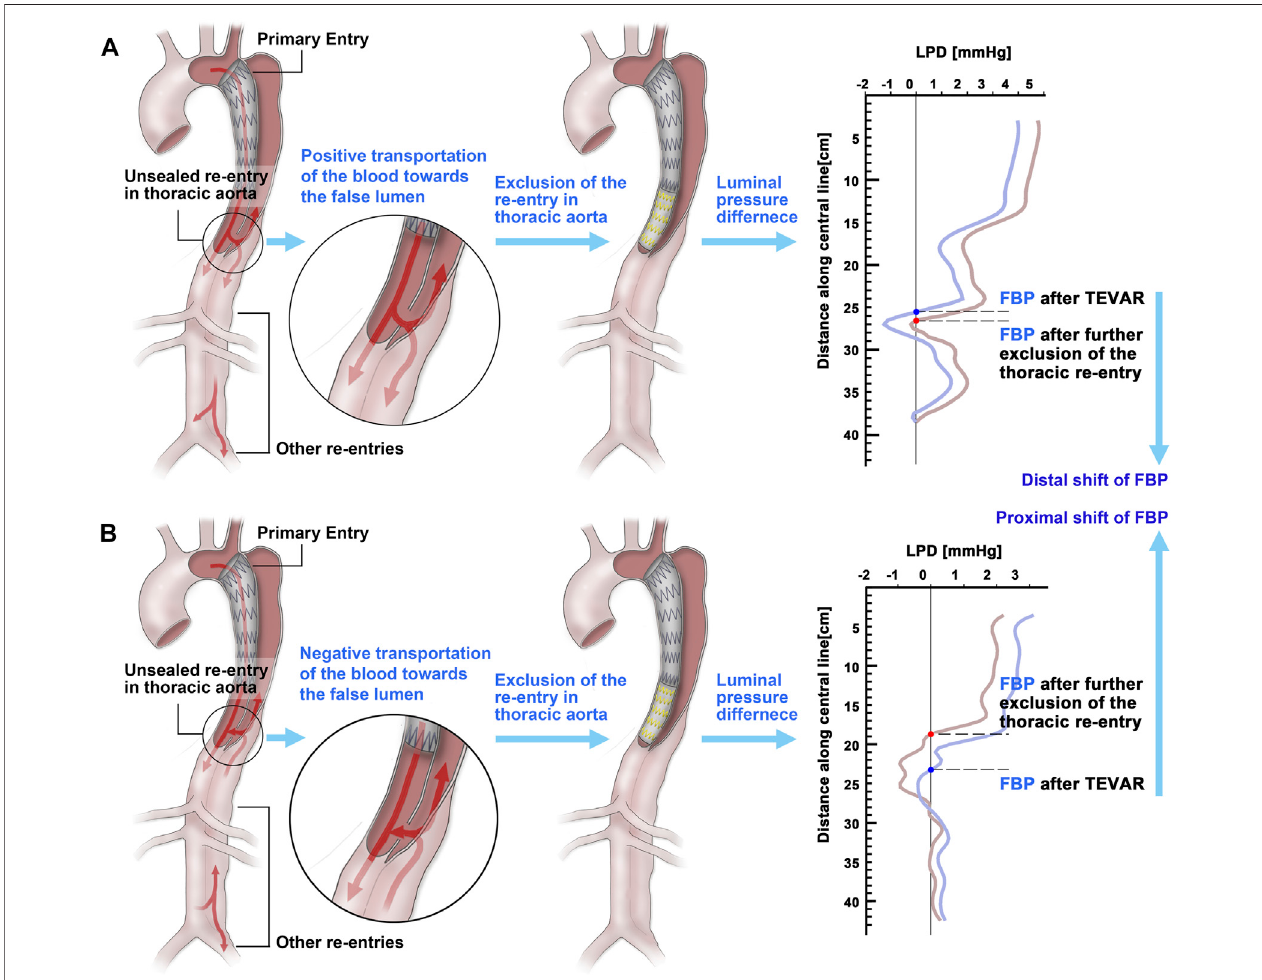
FIGURE 6 | Shift direction of fi rst balance position (FBP) of the luminal pressure difference. (A) The FBP moves tothe distal region if excluding the thoracicre-entry when it contributes to positive transportation of the blood toward the false lumen. (B) The FBP moves to the proximal region if excluding the thoracic re-entry when it contributes to negative transportation of the blood toward the false